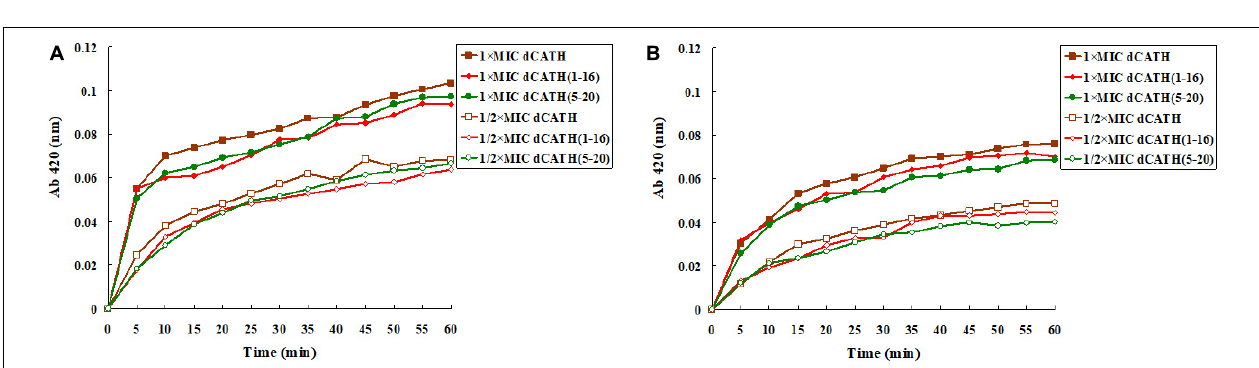
FIGURE 2 | Cytoplasmic membrane depolarization ability of the peptides. Cytoplasmic membrane depolarization ability of the peptides was measured using the membrane potential-sensitive dye diSC3–5. E. coli ATCC 25922 and S. aureus ATCC 29213 were treated by 1 × MIC and 1/2 MIC peptides, and the fluorescent intensity was monitored at an excitation wavelength of 622 nm and an emission wavelength of 670 nm as a function of time. (A) The membrane potential variation of E. coli ATCC 25922 treated by peptides, (B) the membrane potential variation of S. aureus ATCC 29213 treated by peptides.